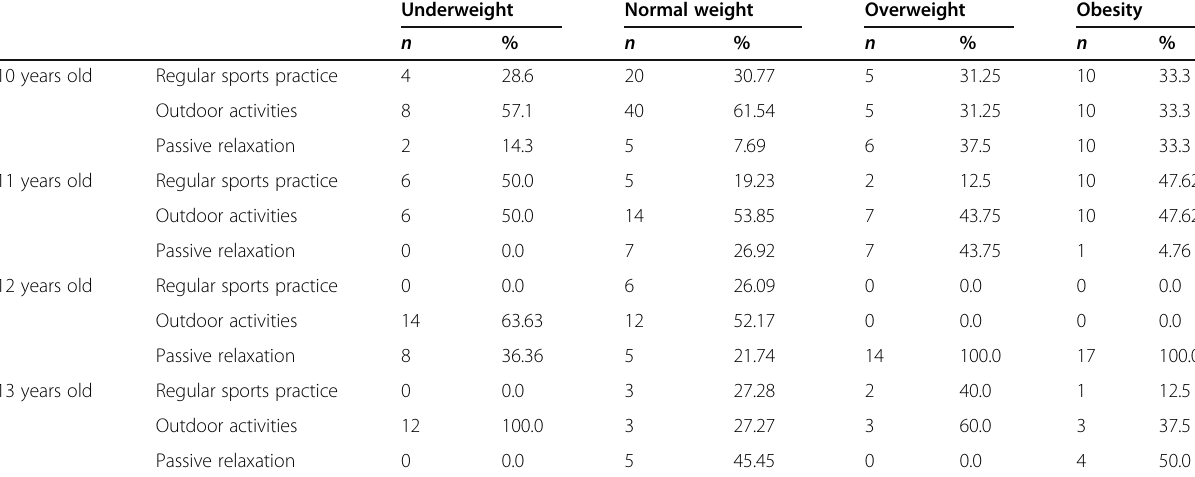
Table 13 The way of spending free time in a group of girls depending on age and BMI level (underweight, normal weight, overweight, obesity)